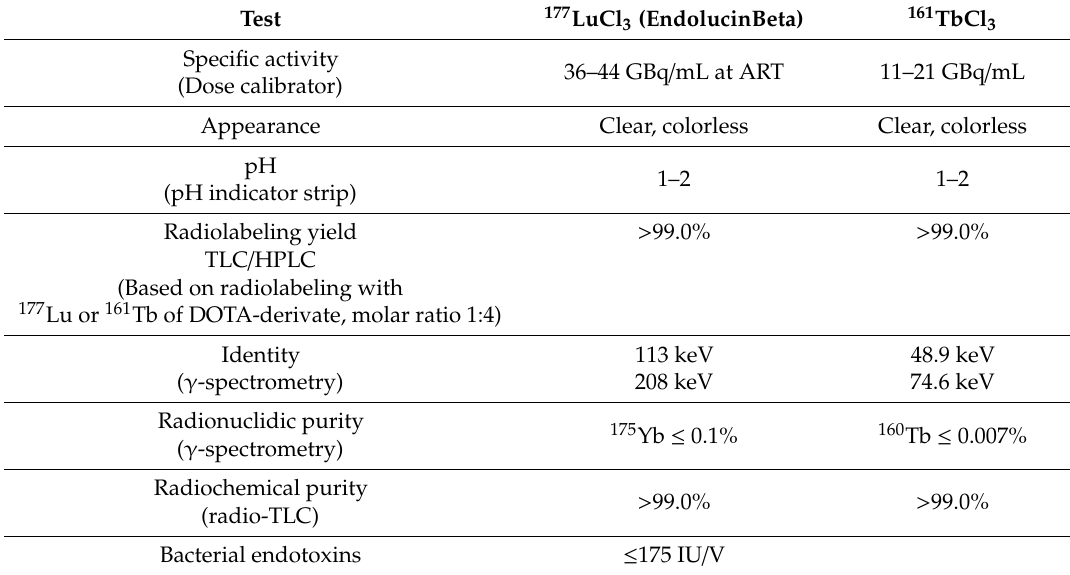
Table 8. Comparison of the specification for 177 LuCl 3 and 161 TbCl 3 [162,173]